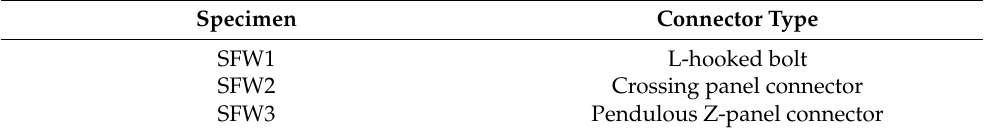
Table 1. Information about the test specimens.